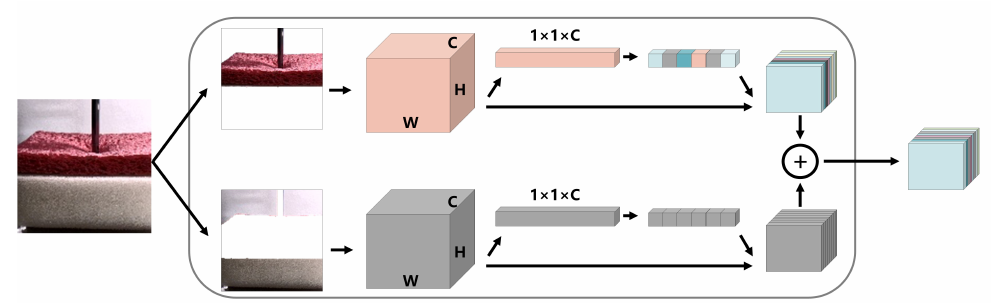
Figure 4. Low-rank foreground-based channel attention